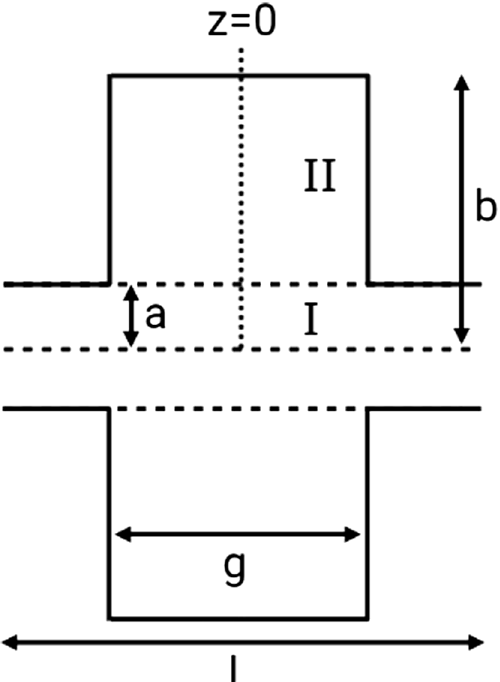
FIG. 29. The cell geometry used to calculate the short-range transverse wakefield where all parameters have their usual meanings. Region I is the beam pipe of the structure and region II is the cell cavity for a < r < b and − L= 2 < z < L= 2